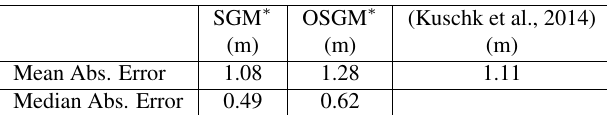
Figure 1: Voxel space to 3D image arrays of stereo pair Similar, to the previous section, the sub voxel height can be com- puted by fitting a quadratic curve around the neighbours of the minimum cost voxel at each grid point. Here, the penalty P 2 is kept constant as it the matching is now done in object space. Fur- thermore, the left right consistency check to find occlusions is not applicable here as there is only one cost array computed in OSGM.